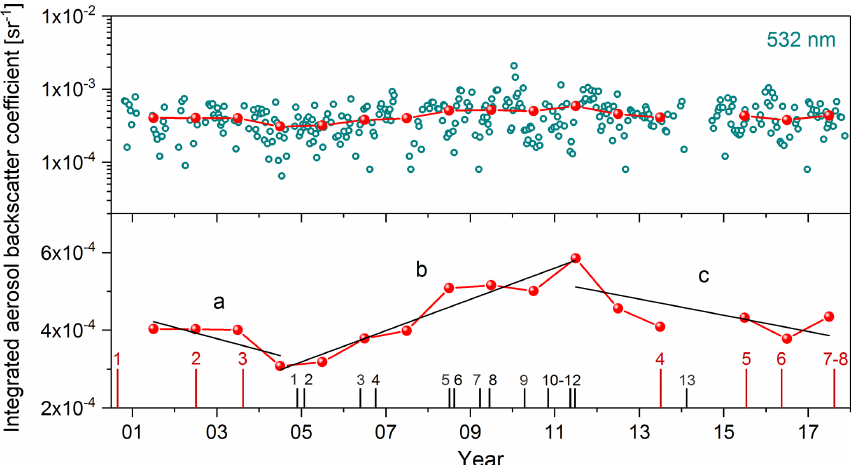
Figure 10. The 2001–2017 time series of the integrated aerosol backscatter coefficient B a obtained from lidar observations at λ = 532nm π, 532 in the 11–30km altitude range. Open dark-green circles denote the 10-day average B a values; solid red circles show the annual average π, 532 B a values assigned to 1 July of each year. Red and black vertical bars in the lower part of the figure indicate, respectively, pyroCbs and π, 532 volcanic eruptions (see also Tables 2 and 3), the plumes of which were observed in the UTLS over Tomsk between 2000 and 2017. The black sloping lines show the trends in the annual average B a values for the 2001–2004, 2004–2011, and 2011–2017 periods. π, 532